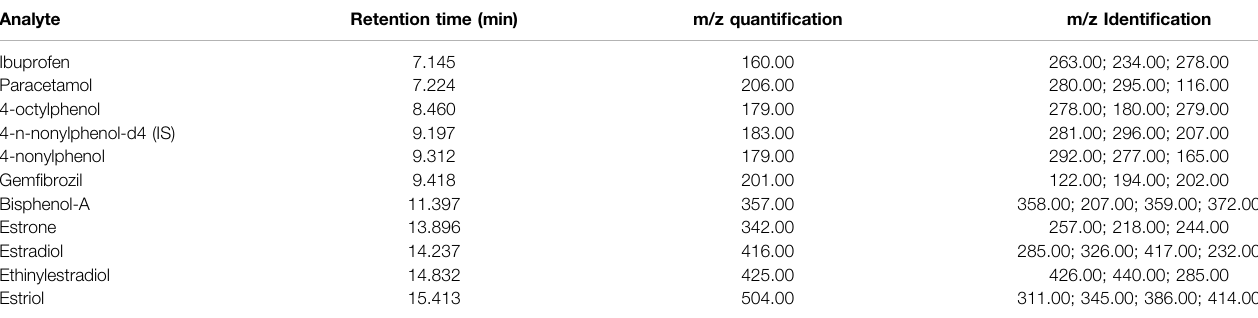
TABLE 2 | Retention times and mass/charge ratios (m/z) of micropollutants analyzed by GC-MS.